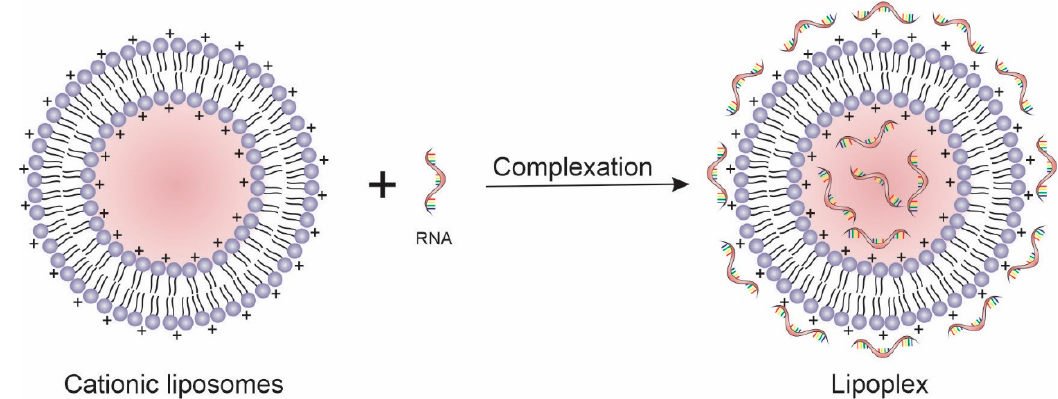
Figure 2. Schematic representation of lipoplex formation.